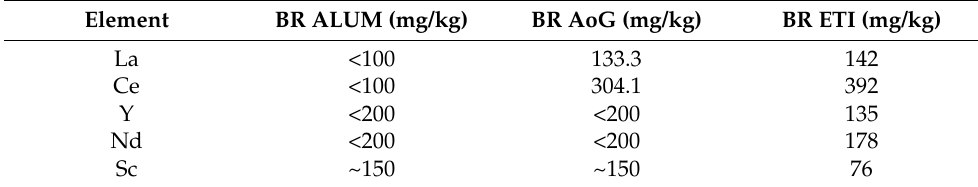
Table 2. Partial chemical composition of Bauxite residue samples (ICO